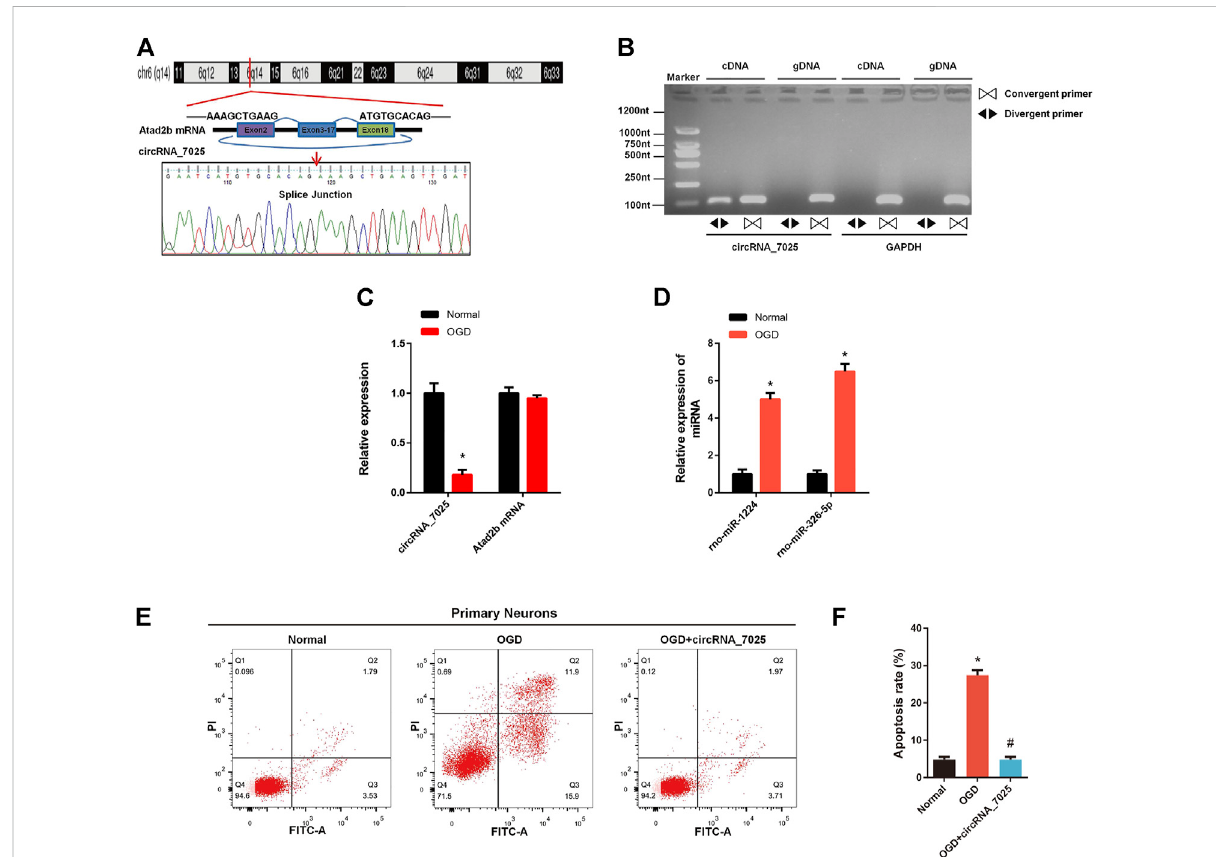
FIGURE 7 Effects of circRNA_7025 on OGD induced neuronal apoptosis. (A) Predicted splice junctions of circRNA_7025 were validated by Sanger sequencing. (B) PCR analysis for circRNA_7025 in cDNA and gDNA. Divergent primers ampli fi ed CircCDH13 from cDNA, but not from gDNA. (C) Relative expression level of circRNA_7025 and Atad2b mRNA after OGD treatment (* p < 0.05, n = 3). (D) Relative expression levels of rno-miR- 1224 and rno-miR-326-5p in neurons after OGD treatment (* p < 0.05, n = 3). (E) The effect of circRNA_7025 on neuronal apoptosis was measured by fl ow cytometry. (F) The results of fl ow cytometry are presented as the apoptosis rate (* p < 0.05 vs. Normal group, # p < 0.05 vs. OGD group, n = 3). OGD, oxygen and glucose